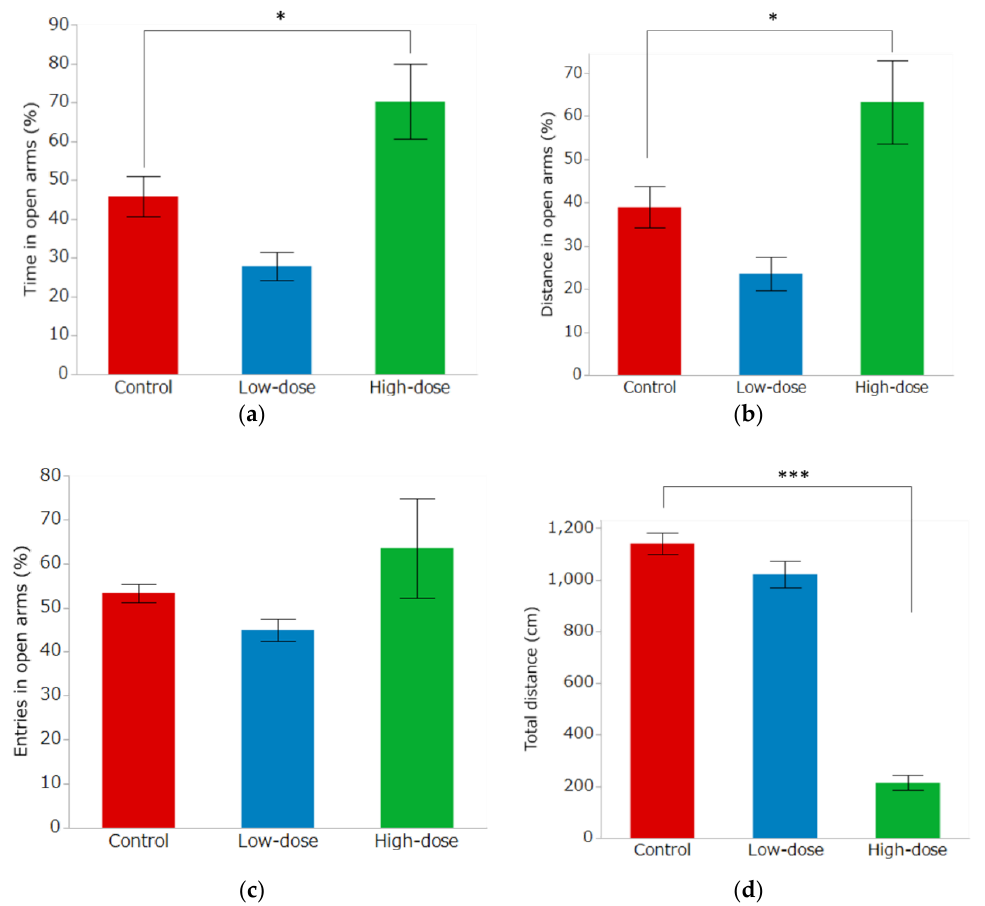
Figure 6. Behavioral effects of IMI administration in the elevated plus maze test. The percentage of time ( a ) and distance ( b ) spent in the open arm were significantly higher in the high-dose group than in the control group. ( c ) There were no significant differences in the percentage of entries in the open arm. ( d ) The total distance traveled was significantly decreased in the high-dose group. Bar graphs indicate the mean ± SE of each group. ( n = 8/group), * p < 0.05, Dunnett’s test ; *** p < 0.001, Dunnett’s test .